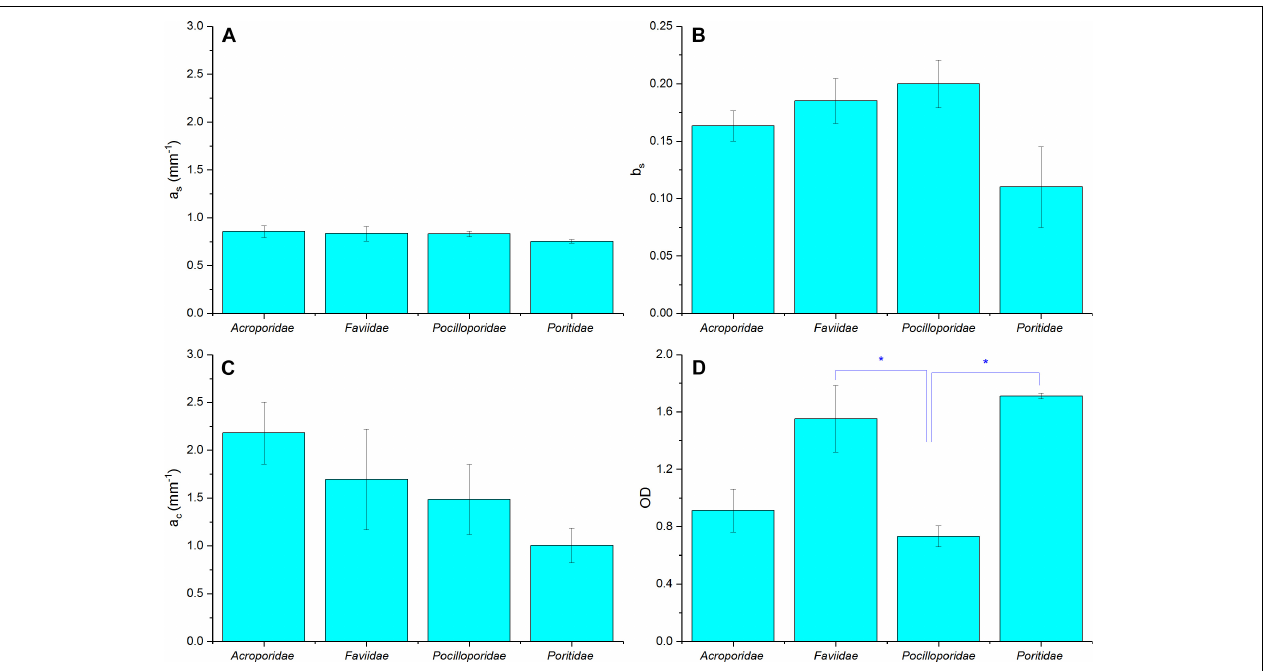
FIGURE 7 | Summary of optical properties of tissue and skeleton for four different coral families. (A) Skeletal scattering coefficient @ 500 nm (a s , mm − 1 ), (B) Skeletal scattering power (b s ), (C) Tissue scattering coefficient @ 500 nm (a c , mm − 1 ), (D) Optical depth (OD). Data are means ± SE for Acroporidae ( n = 9) , Faviidae ( n = 8) , Pocilloporidae ( n = 5), and Poritidae ( n = 3). Significant differences ( p < 0.05) are marked with